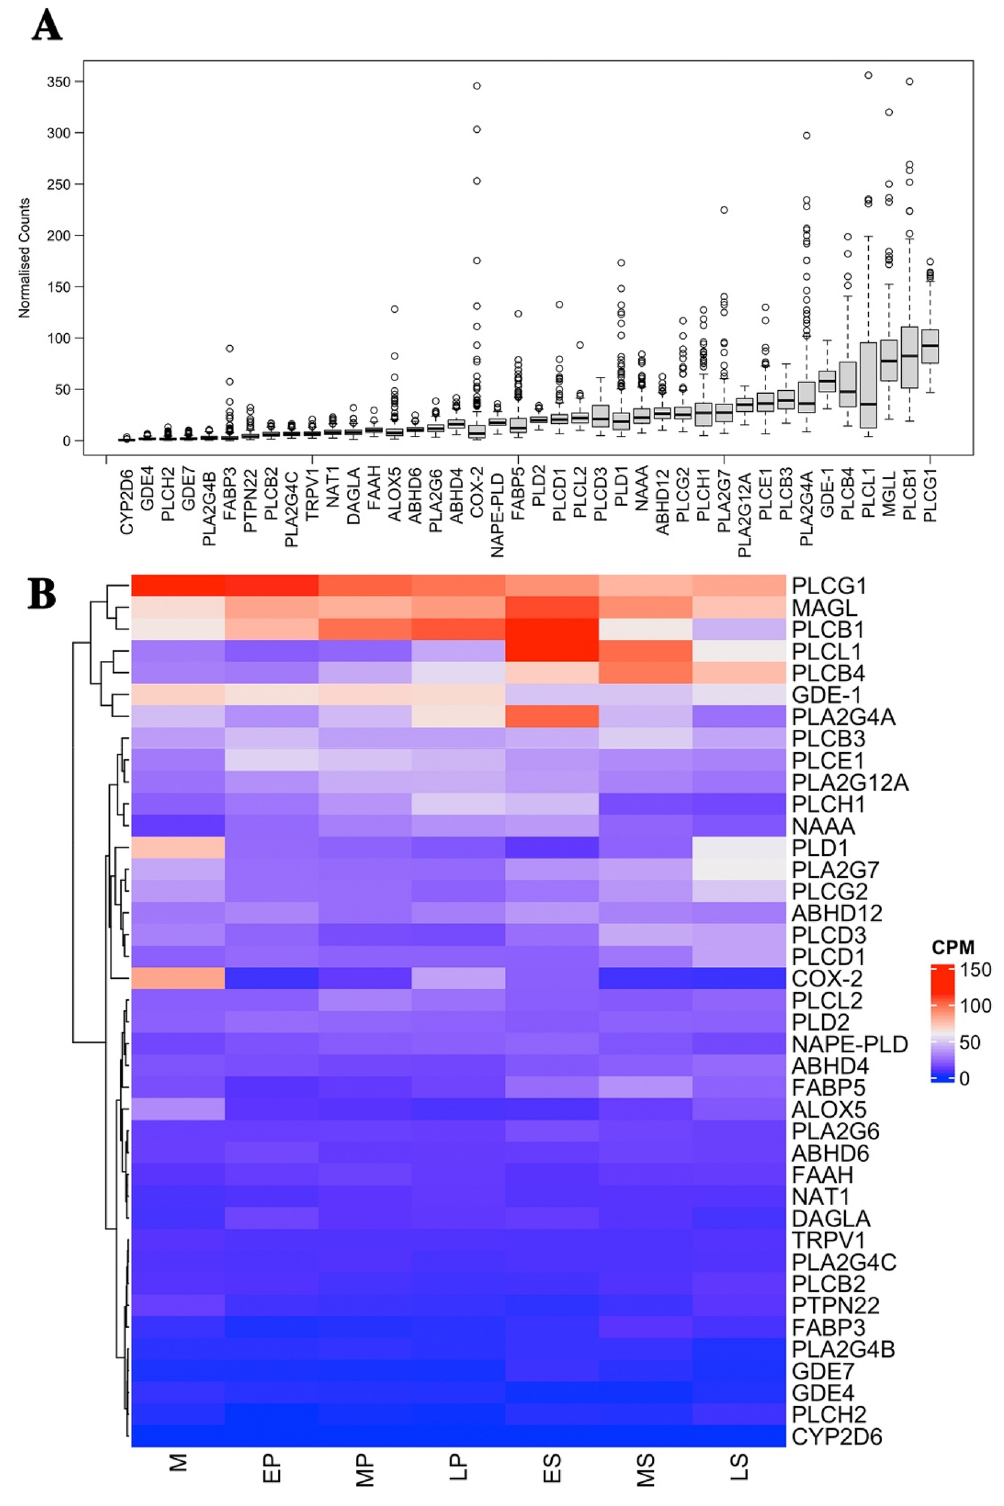
Figure 1. Gene expression of ECS genes in endometrium across the menstrual cycle. ( A ) Using 206 endometrial samples we found that of the 70 genes identified through the literature to function as part of ECS, 40 were expressed in at least 90% of the samples. The level of expression of each gene varied significantly between individuals and mean expression varied between genes. ( B ) A heat map analysis identifying the relative expression (cpm) of each gene across the menstrual cycle. The stage variation identified for some of these genes could be explained in part by differences that occurred in expression across the menstrual cycle. M = Menstrual, EP = Early proliferative, MP = Mid proliferative, LP = Late proliferative, ES = Early secretory, MS = Mid secretory, LS = Late